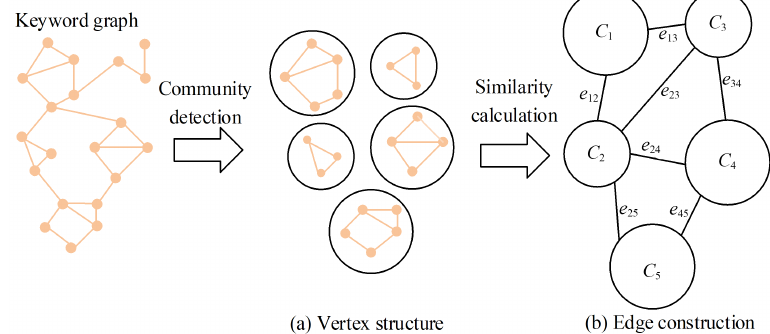
Fig. 2 Process of CSG construction. C i represents the i -th subgraph and e ij represents the weight of the edge between C i and C j